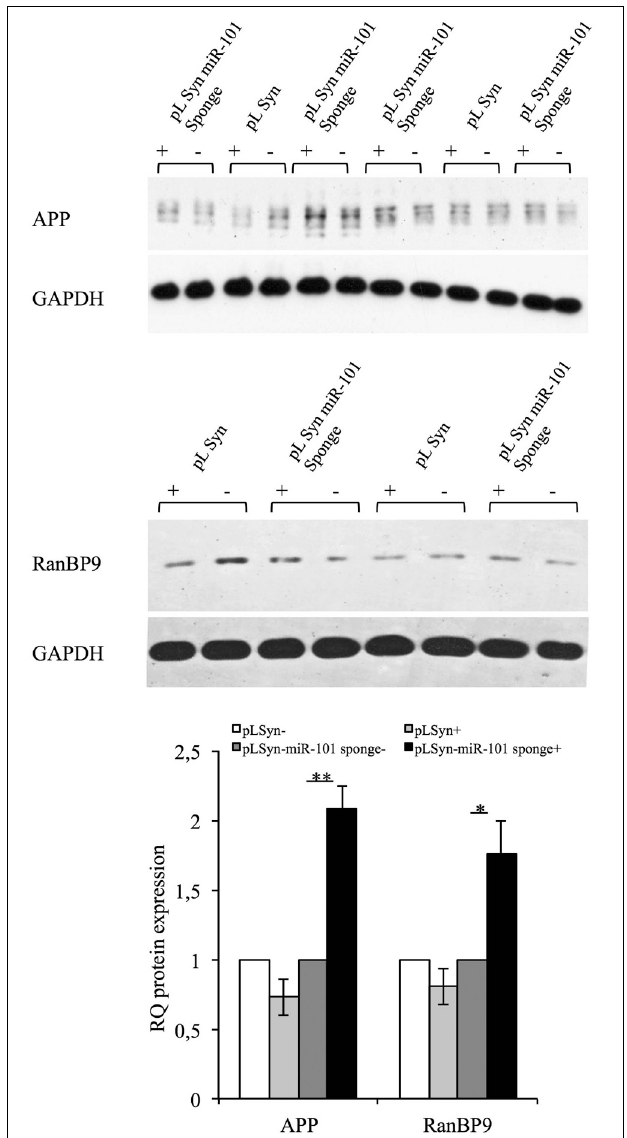
FIGURE 5 | Full-length APP and RanBP9 are targets of miR-101 in mouse hippocampal neurons in vivo. Western blotting was performed of hippocampal tissues injected and non-injected with lentiviral vectors. Effective expression of the lentiviral vector was revealed by the presence of EGFP (data not shown). Expression of the miR-101 lentiviral sponge resulted in an increase in the protein expression levels of the miR-101 targets, APP and RanBP9, with respect to non-injected tissue. APP and RanBP9 band intensities were quantified by densitometry, normalized to the GAPDH signal, and expressed as arbitrary OD units. The relative ratio of APP (pLSyn n = 3; pLSyn-miR-101 sponge n = 4) and RanBP9 (pLSyn n = 3; pLSyn-miR-101 sponge n = 4) expression in injected vs. non-injected tissue is shown. Results are presented as the means ± the SE ( ∗ p < 0 . 05; ∗∗ p < 0 . 01, Student’s t